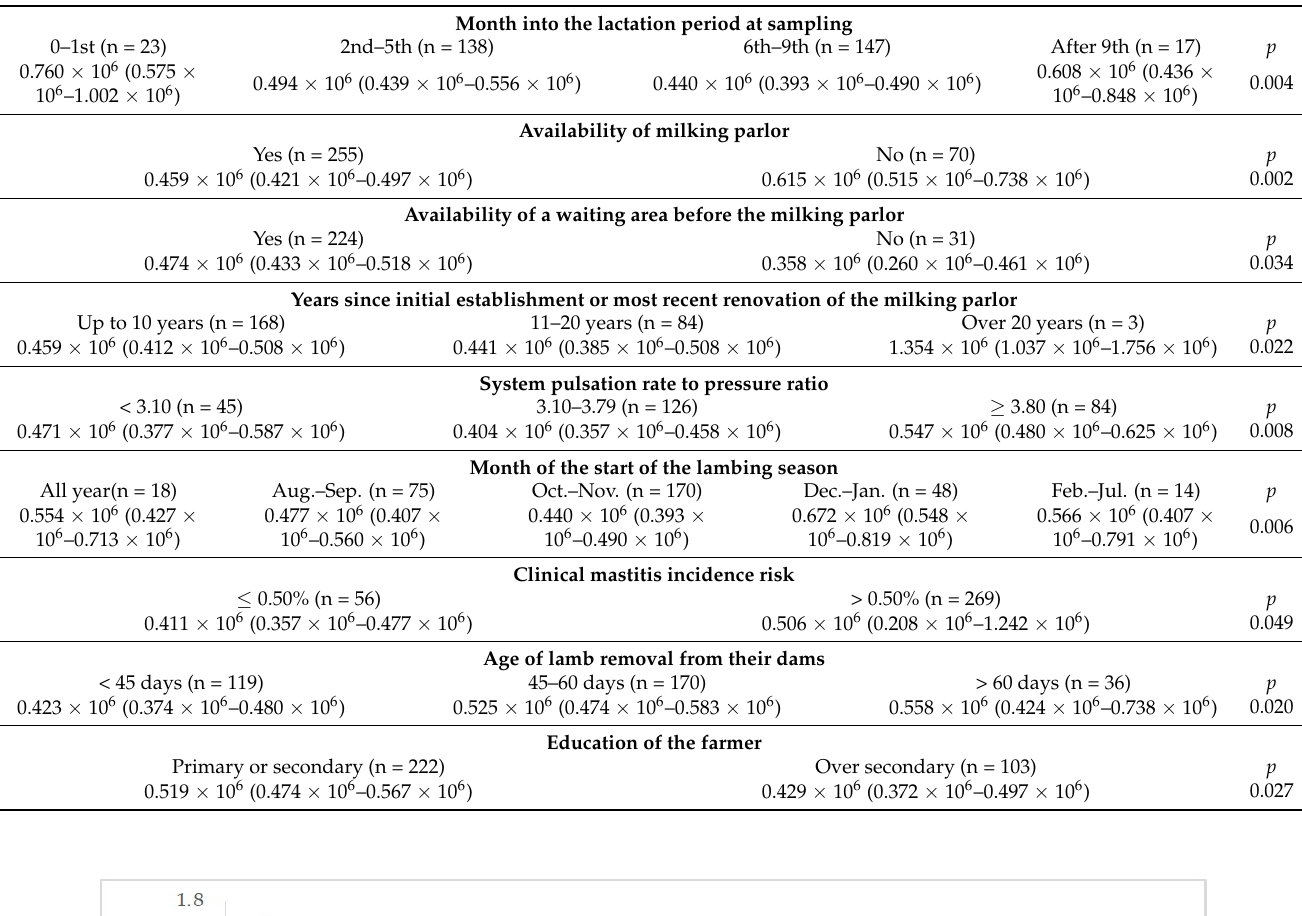
Table 4. Factors (n = 9) with significant variations between their categories with regard to somatic cell counts (geometric mean [95% confidence intervals] cells mL − 1 ) in the bulk-tank milk of 325 sheep flocks in Greece.